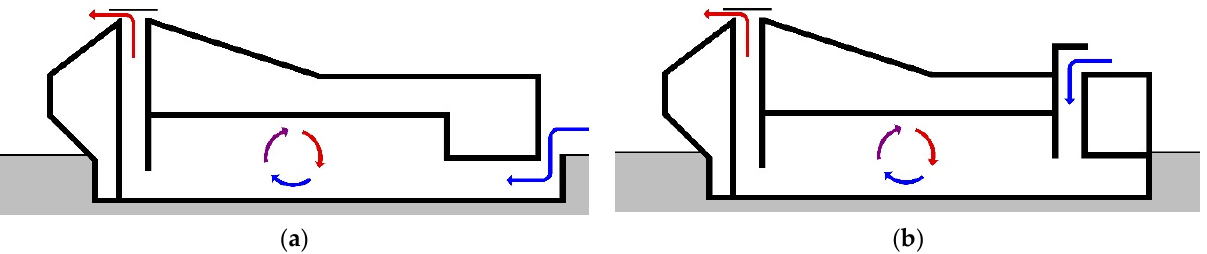
Figure 2. The two investigated PACS method: ( a ) updraft (UD) and ( b ) down drought (DD).